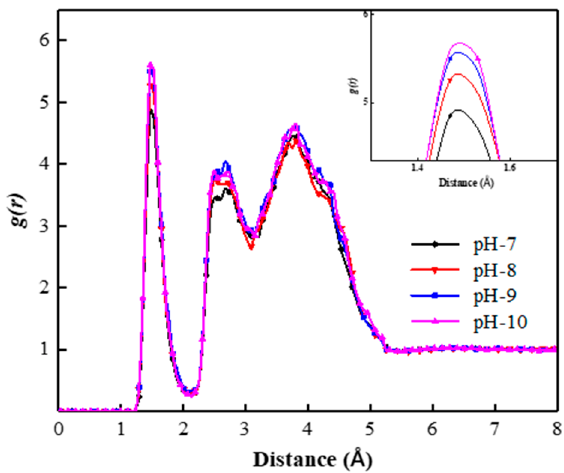
Figure 14. Radial distribution functions of SDBS head group and surrounding water molecules in foam systems with different pH. Table 3. Coordination numbers of water molecules in the hydration shells of foam systems with different